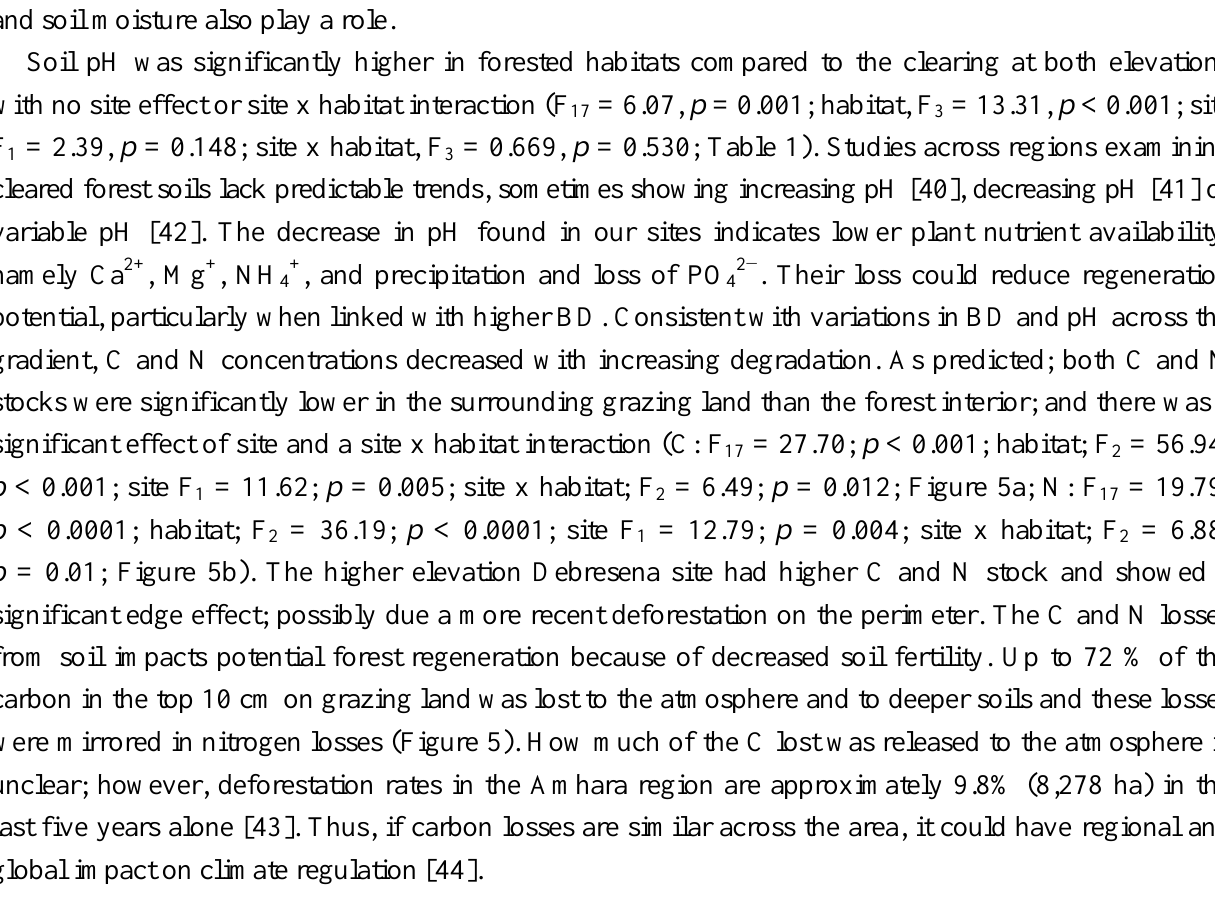
Table 1. Mean (+/-SE) of soil properties and foliar chemistry in soils collected from three habitats in or around two tropical dry montane forest fragments in northern Ethiopia (Site 1 = Zahara; Site 2 = Debresena).